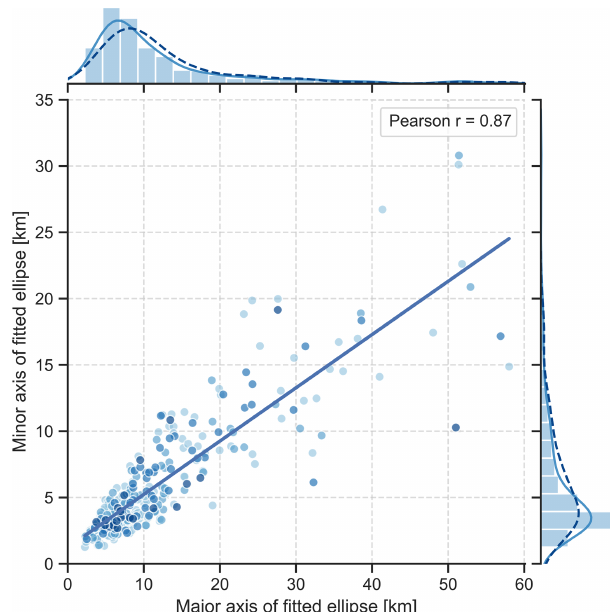
Figure 2. Length of major and minor axes (in kilometres) of fit- ted ellipses for each FAE, assuming an altitude of 110km. FAEs are shaded according to confidence groups, with darker shades be- ing FAEs of higher quality. A histogram of the variables is plotted on the outer axes, together with a KDE. The dashed KDE line is only calculated for FAEs of groups 1 and 2. The legend shows the calculated statistical Pearson correlation coefficient for a linear re- gression, with a p value (cid:28) 0.01, which rejects the null hypothesis.